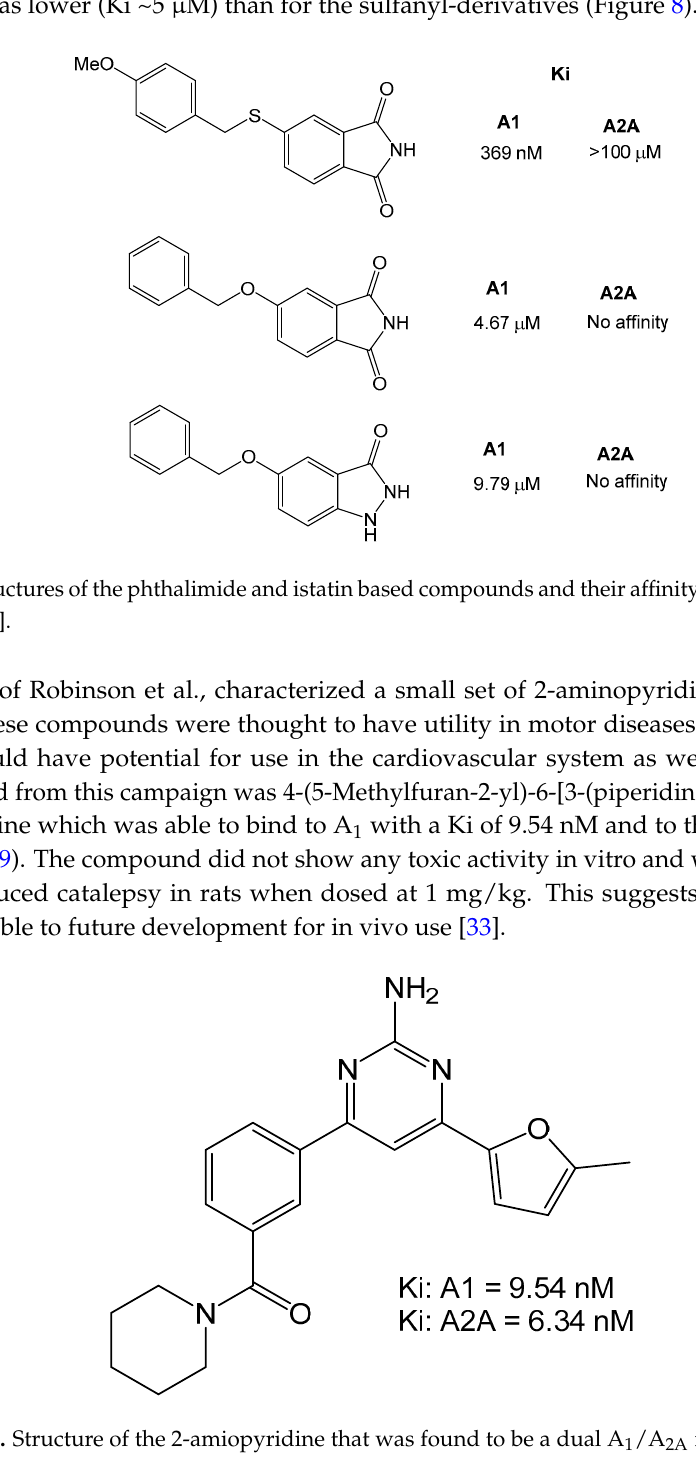
1 /A 2A receptor